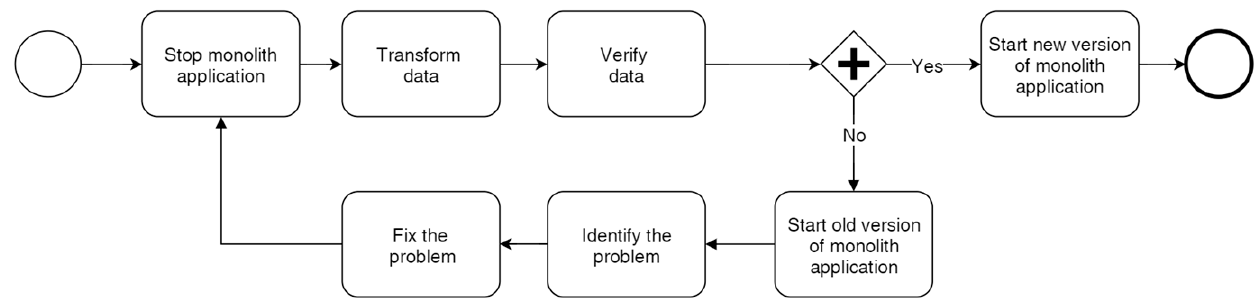
Figure 11. Release and deployment execution.